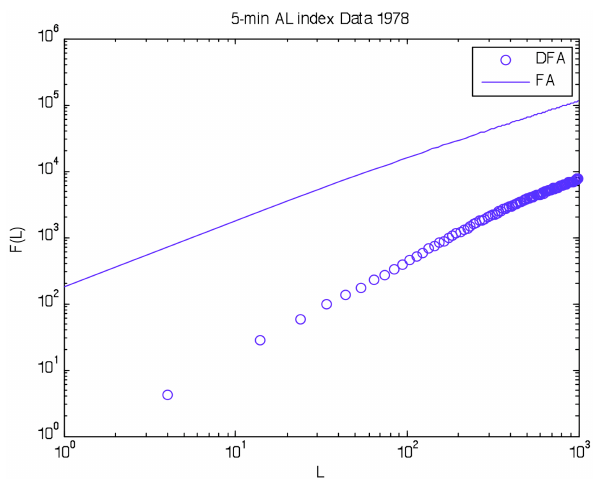
Fig. 6. Detrended fluctuation analysis of 5-min averaged data of AL for 1978. The scaling of F(L) is similar to the case of 1-h averafed data (Fig. 5). The fluctuation analysis (FA) shows a different scaling exponent for L ∼